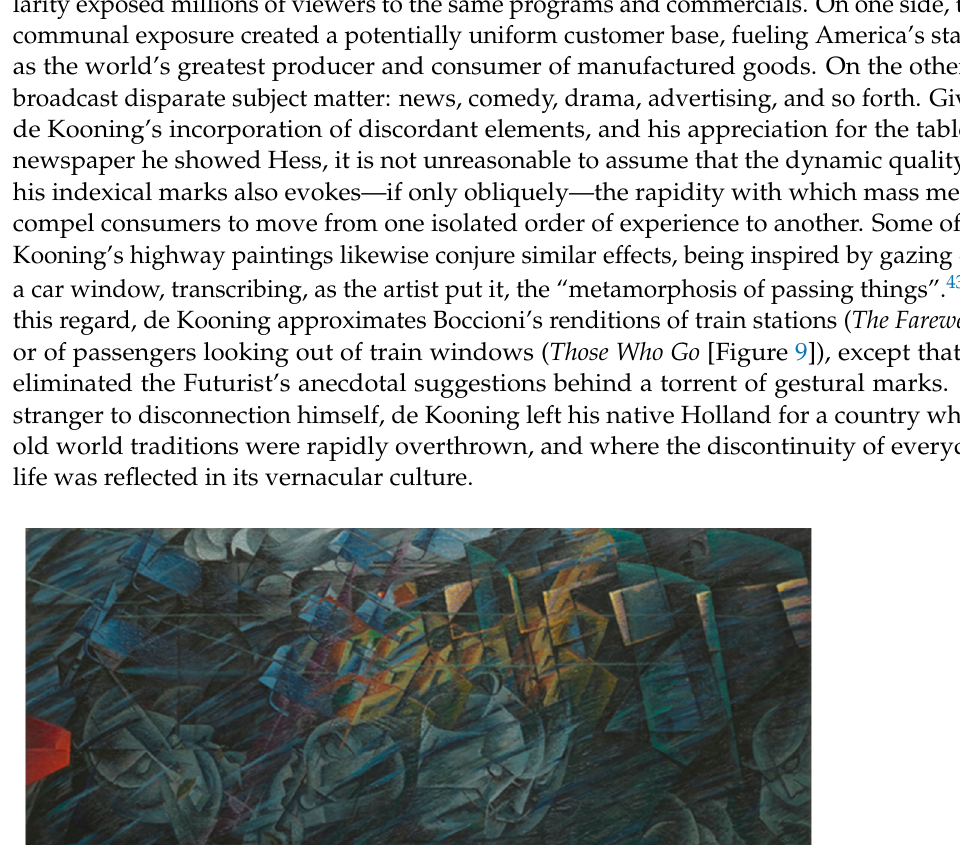
Figure 9. Umberto Boccioni, States of Mind II: Those Who Go , 1911, oil on canvas, Museum of Modern Art, New York, Gift of Nelson Rockefeller.